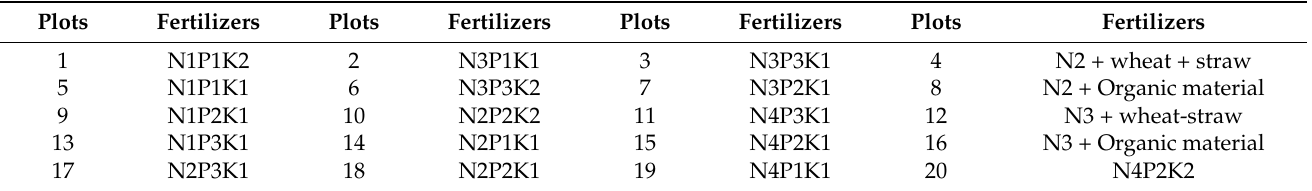
Table A2. The result of linear regression analysis between SIs and SPAD values for different growth stages. The spectral indices mean different information, and the stages are in according with the date of data acquisition in Figure 3. The Equation represents the linear regression equation, R 2 means the coefficient of determination, and the p means the significant values.